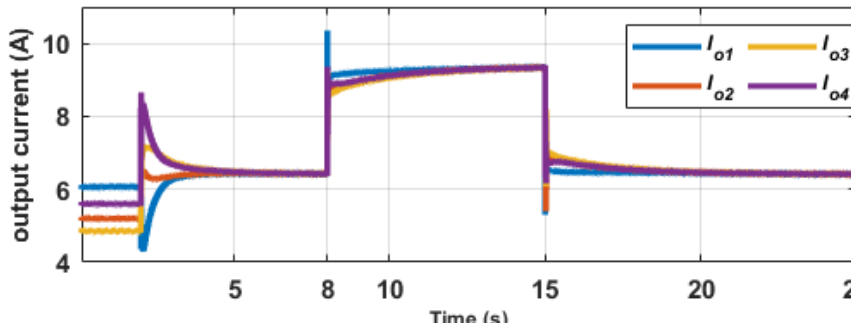
Figure 11. Output currents of DGs.